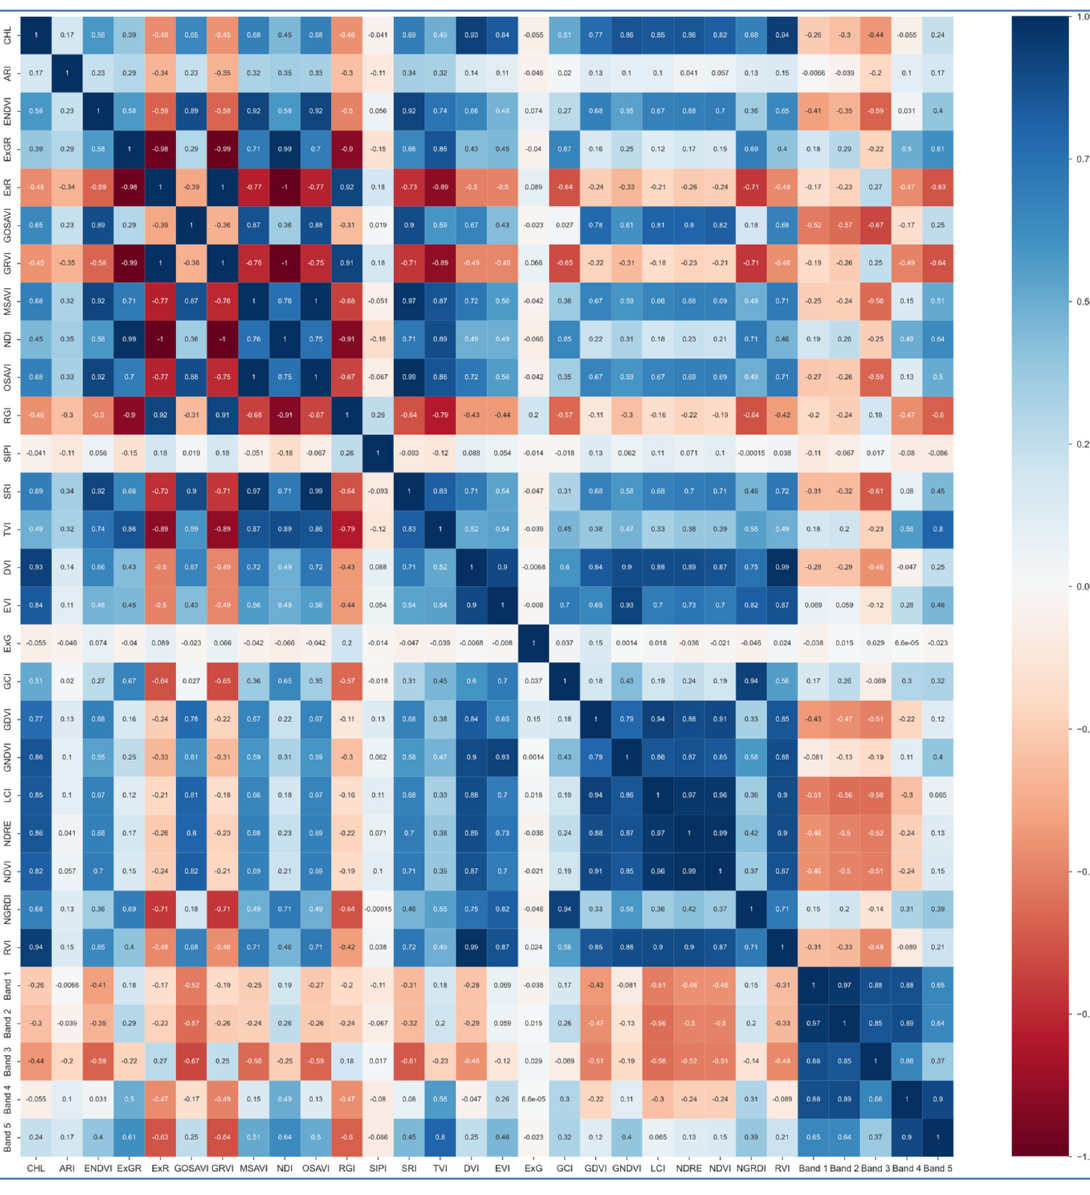
Figure A1. Correlation matrix plot between chlorophyll content and different vegetation indices